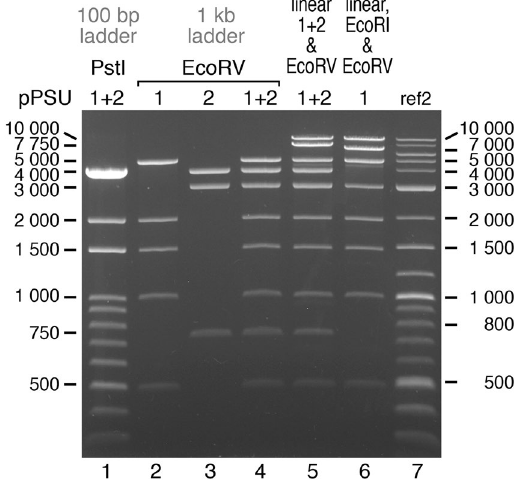
Figure 4. Penn State DNA ladders on agarose gel. The 100 bp (PstI) and 1 kb (EcoRV) Penn State DNA ladders are shown together with the New England Biolabs 2-Log DNA ladder on a 1% agarose gel. Lane 1: 100 bp marker created by PstI digestion of the pPSU plasmids. Lanes 2–4: EcoRV digests of pPSU1 and pPSU2 separately and combined to produce the standard 1 kb Penn State MW Marker. Lane 5: Expanded 1 kb ladder produced by combining the standard 1 kb ladder from lane 4 with NcoI-linearized pPSU1 and pPSU2 to provide additional 7750 and 10000 bp fragments. Lane 6: The 1 kb ladder produced from pPSU1 alone by combining NcoI, EcoRI and EcoRV digests. The faint band migrating between 4000 and 5000 bp in lanes 5 and 6 is likely produced by NcoI star activity. Lane 7: New England Biolabs 2-Log DNA ladder (ref2).